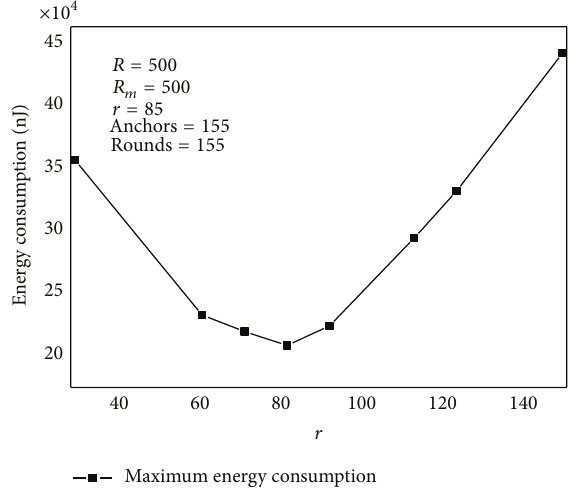
Figure 15: Maximum energy consumption under different 𝑟